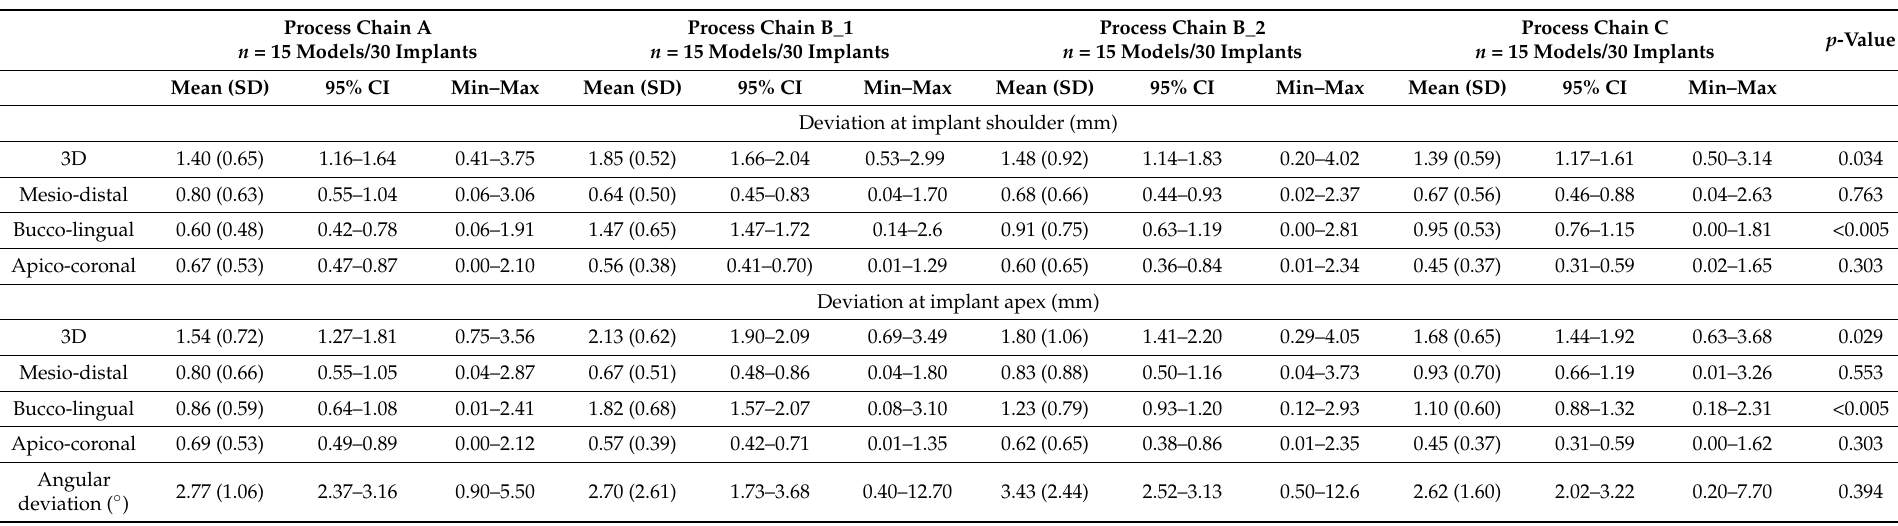
Table 3. Deviations between the planned and clinically-achieved implant